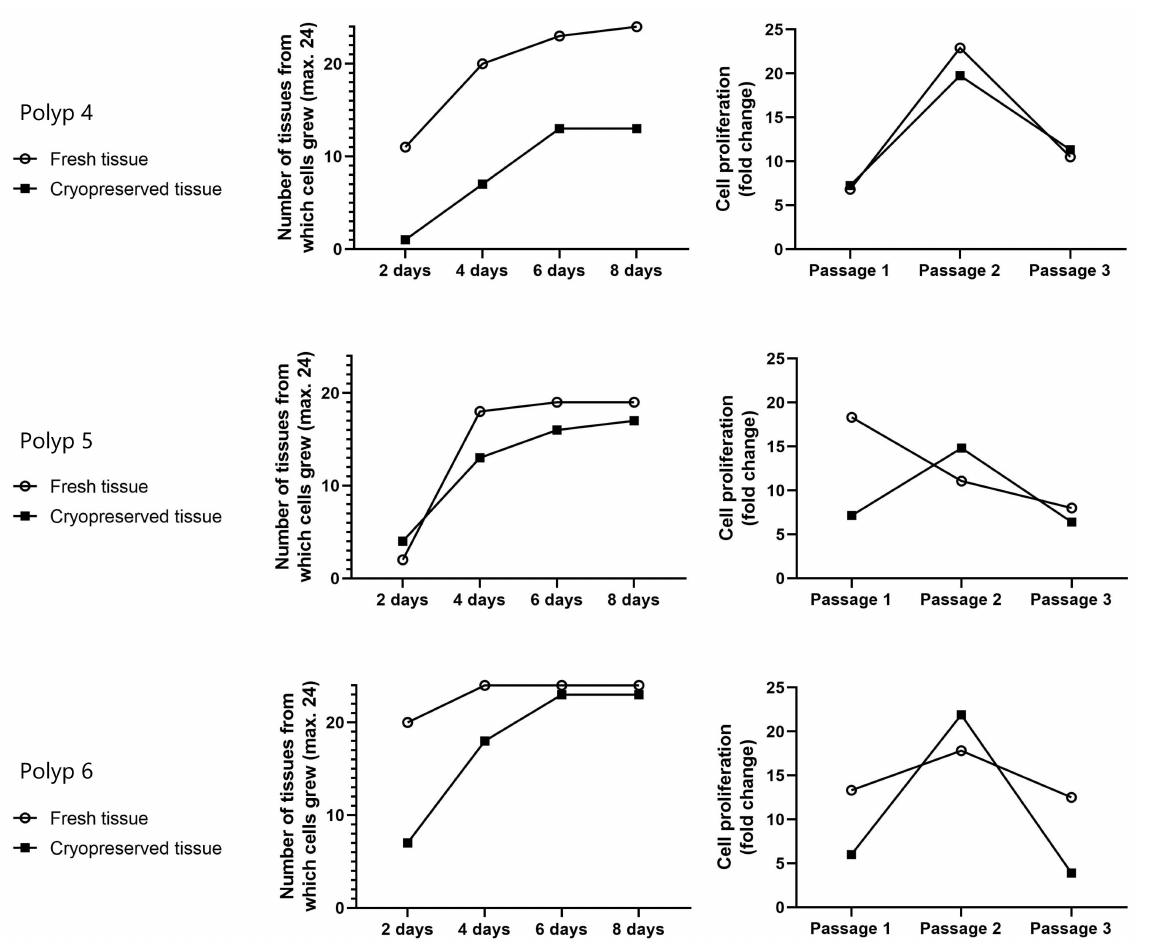
Figure 3. Outgrowth and proliferation of epithelial cells from 3 fresh tissues and their cryopreserved tissues (Polyp 4, Polyp 5, and Polyp 6) were compared. Tissue was cut into small pieces, and 24 small tissue pieces per sample were cultured for the isolation of epithelial cells by outgrowth. The outgrowth was assessed every 2 days for 8 days. To evaluate the proliferation, cells were transferred to a 6-well plate at 5000 cells per well (total 30,000 cells) on day 8 of outgrowth, and the number of cells from 6 wells together was counted every 6 days until the 3rd passage. See Appendix A for detailed data.